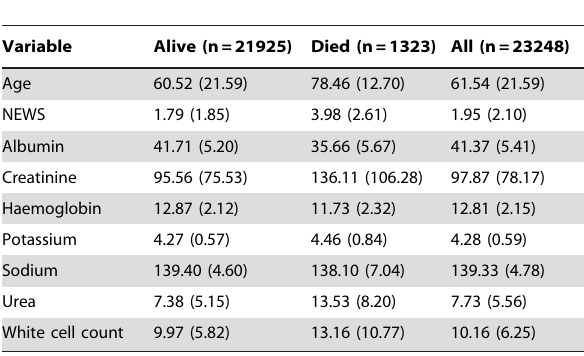
Table 1. Mean and (standard deviation) for the continuous covariates in the Tree